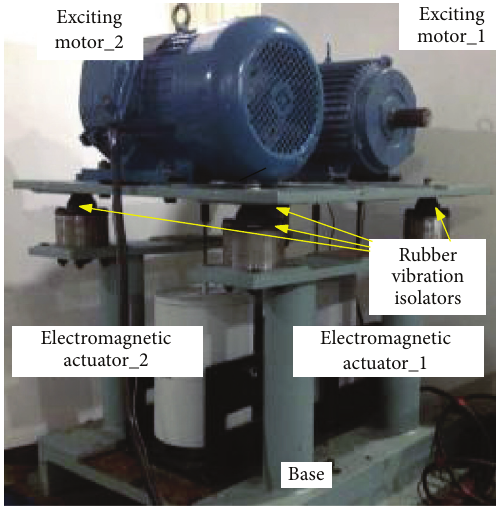
Figure 20: Multisources complex excitations active vibration isola- tion experimental